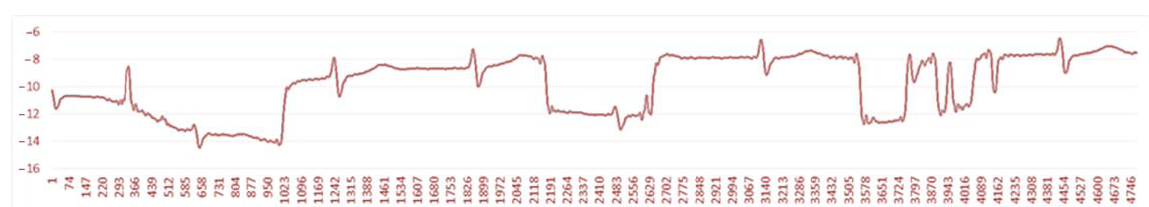
and slopes. ECG elements differ.